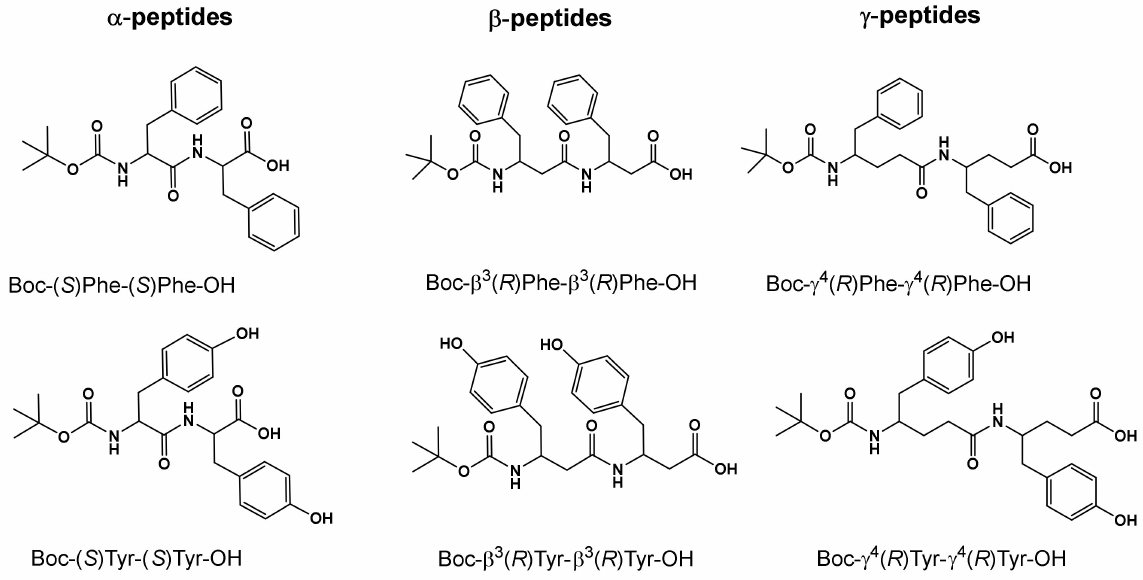
Figure 1. Molecular structures of the Boc-diphenylalanine and Boc-dityrosine analogues used in this